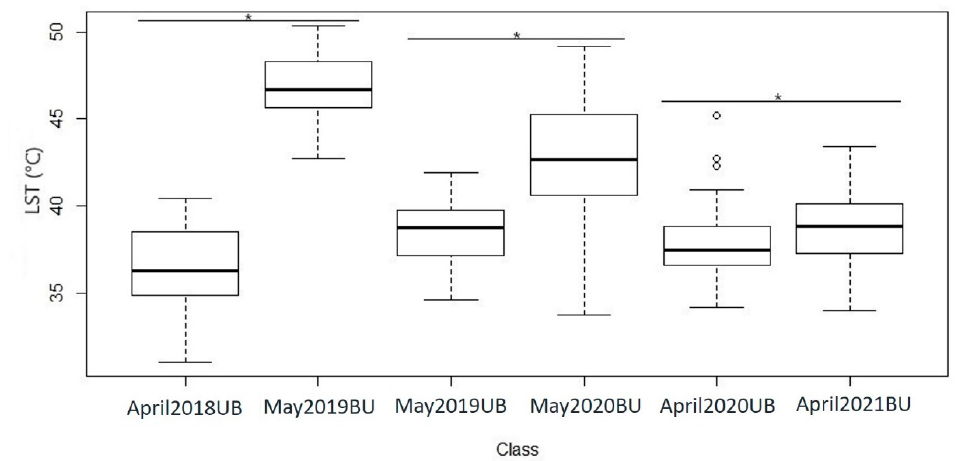
Figure 6. Mean and distribution of LST values of unburned sites (UB) for the dates April 2018, May 2019 and April 2020, and burned sites (BU) for the dates May 2019, May 2020 and April 2021 assessed by the ANOVA statistical test ( p < 0.05 *).